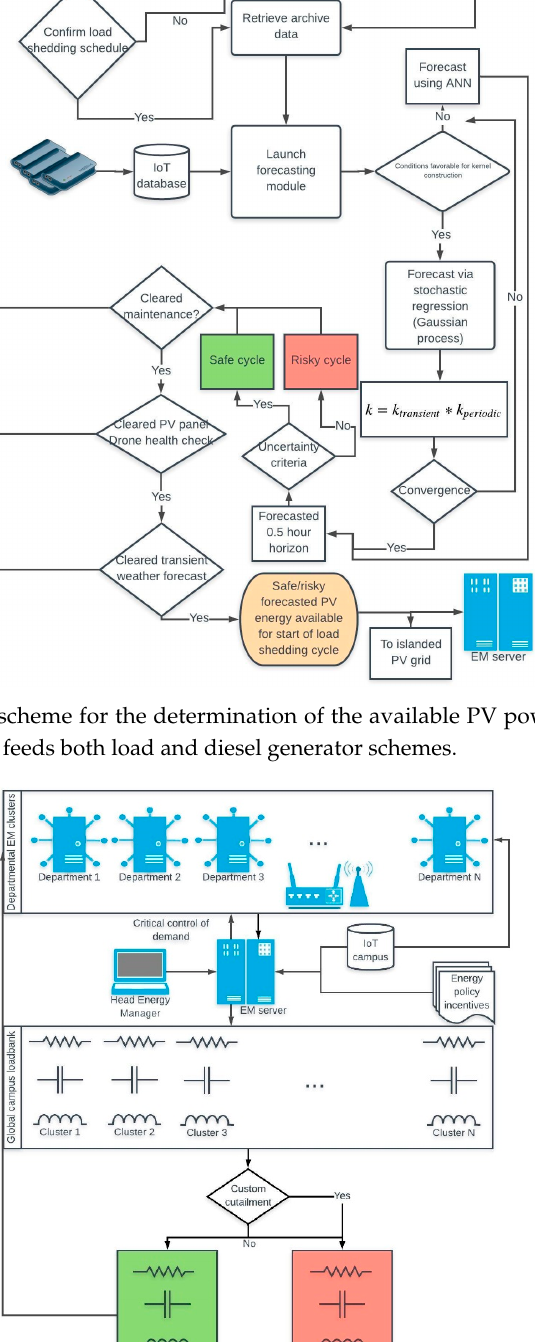
Figure 3. Optimization scheme for diesel generator—load interactions based two classes, namely variable and locked banks.